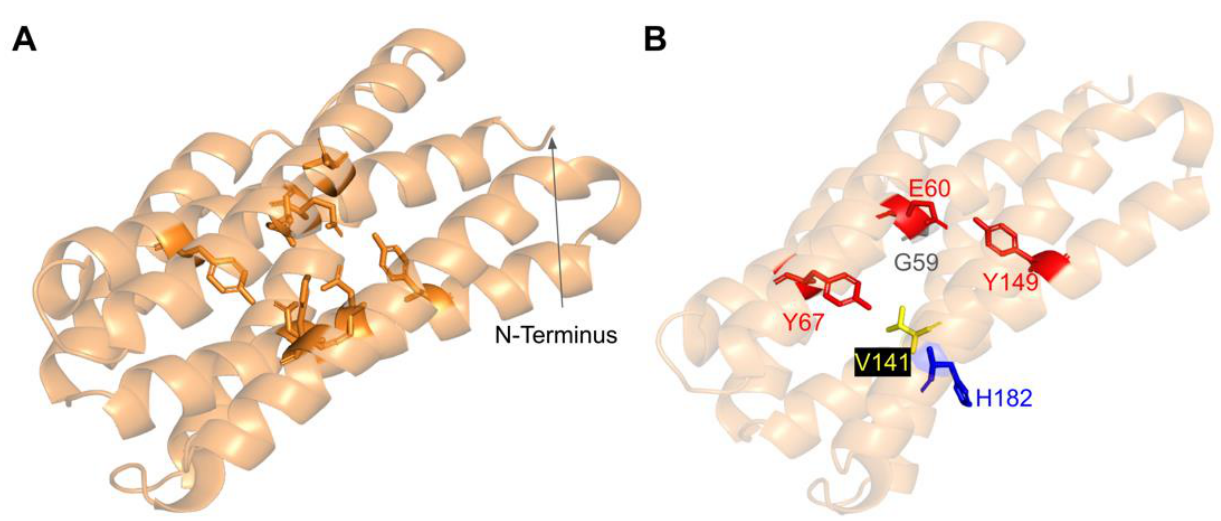
Figure 27. SNVs found in COQ7 residues that are adjacent to or that ligand the iron atoms. ( A ) The residues predicted to ligand the Fe (II) atoms are depicted in orange on the COQ7 model; E60, Y67, E90, H93, E142, Y149, E178, and H181. ( B ) Locations of SNVs are depicted. Residues are colored according to their corresponding SNVs in Figure 24. Residues 1 – 43 have been truncated in both panels.